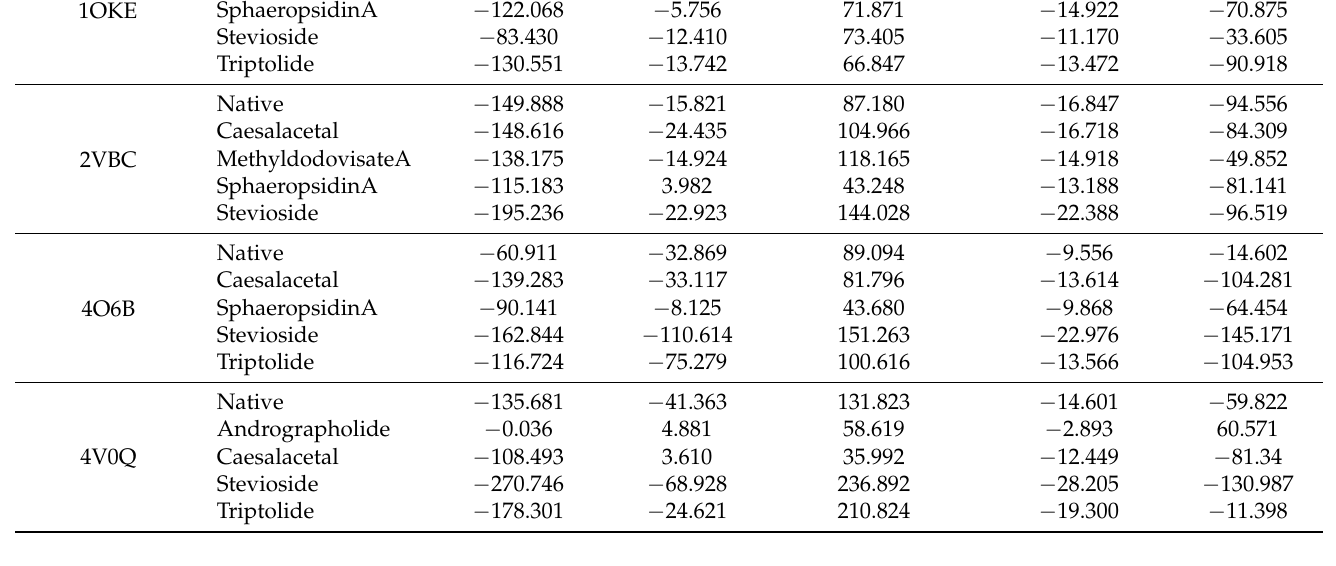
Figure 9. The RMSF plot for the backbone atoms for ( A ) 1OKE, ( B ) 2VBC, ( C ) 4O6 Band ( D ) 4V0Q.